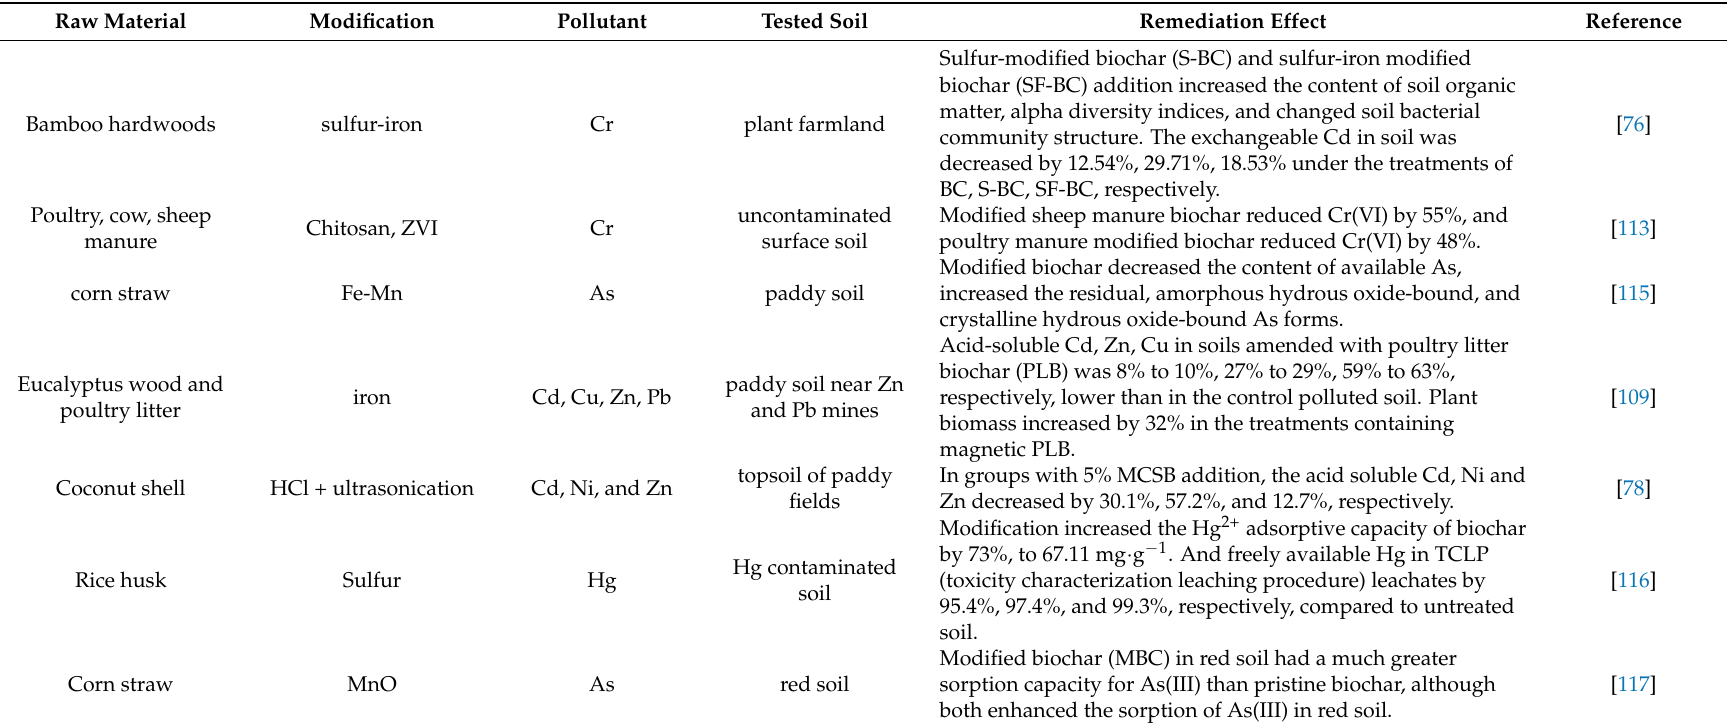
Table 5. The remediation of soil pollution by various types of modified